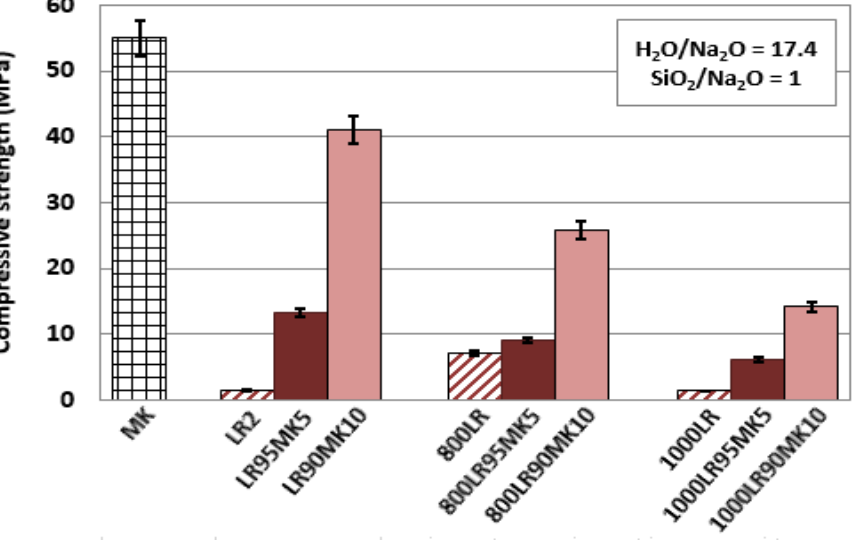
Figure 2. Effect of calcination temperature and addition of MK (5 wt% and 10 wt%) to LR on the compressive strength of the produced AAMs (pre-curing time, 4 h; curing temperature, 80 ◦ C; curing period, 24 h; ageing period, 7 days; error bars denote standard deviation of measurements obtained from three specimens).